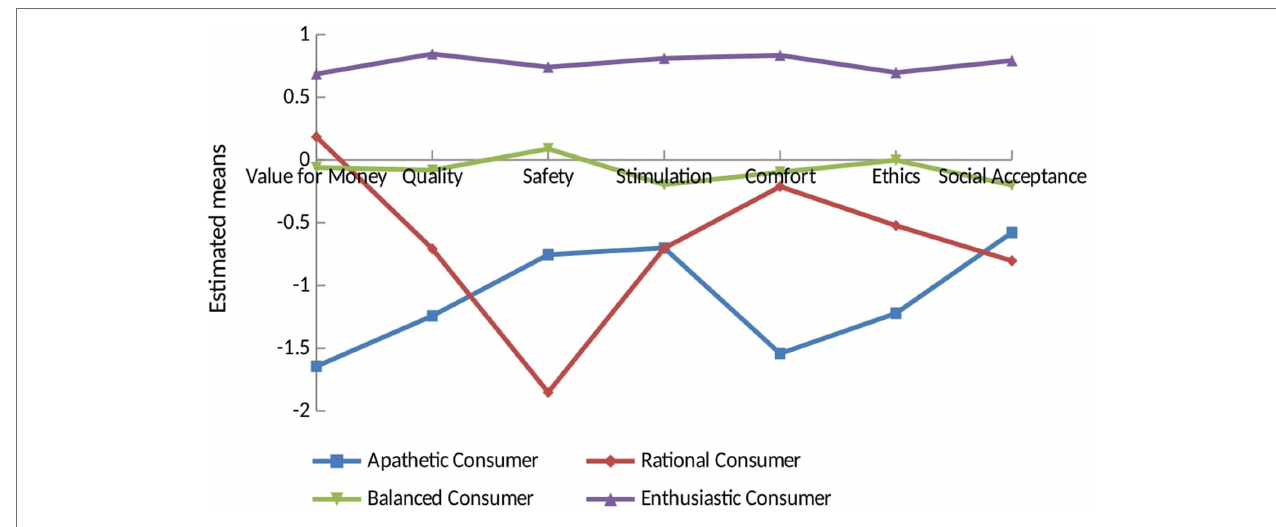
FIGURE 1 | Latent profiles of different consumer motivation segment ( N =